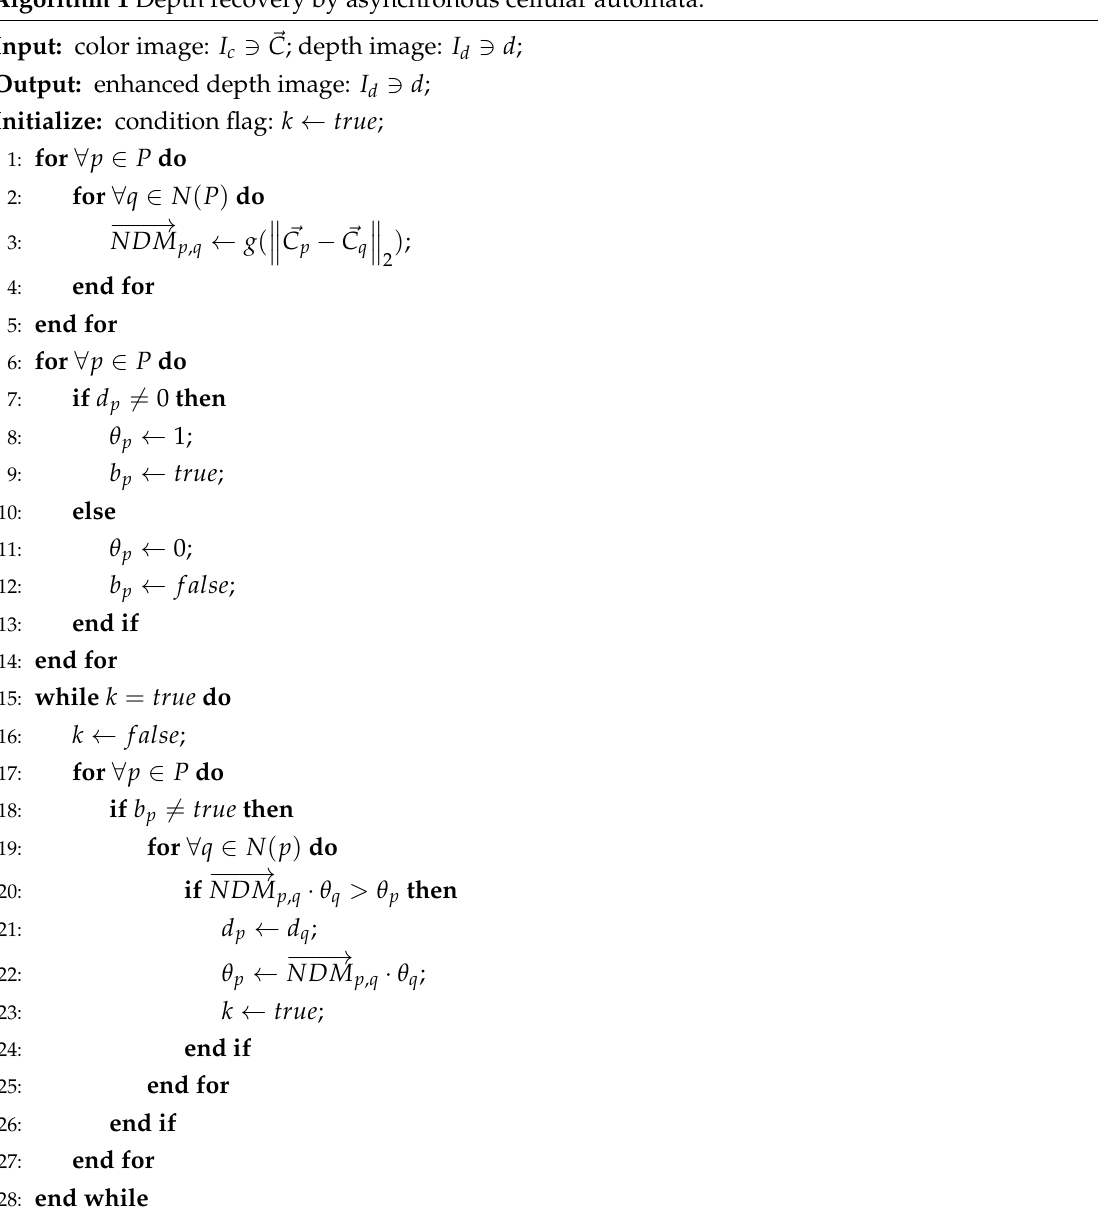
Algorithm 1 Depth recovery by asynchronous cellular